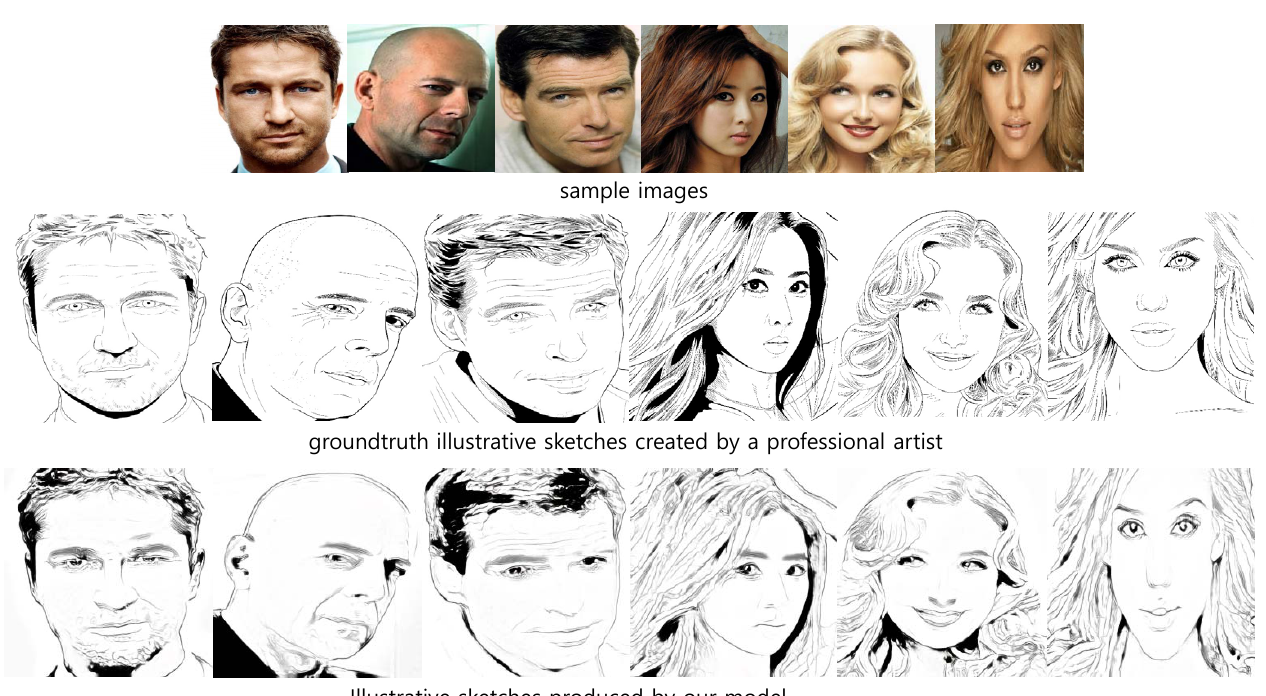
Figure 8. Our illustrative sketch portraits compared to the groundtruth artwork sketches produced by a professional